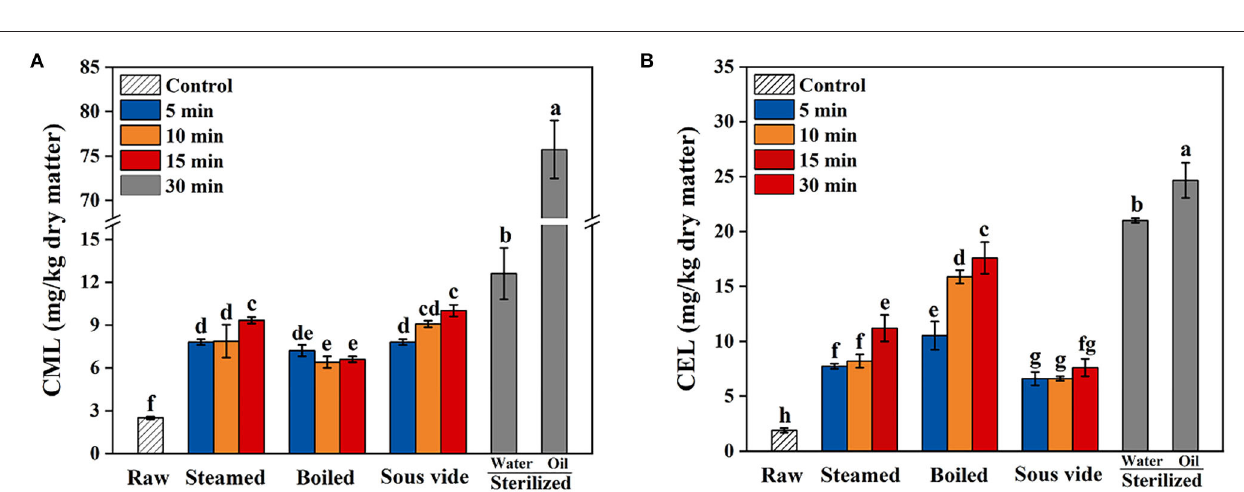
TBARS value of fried filets was about one-half of the boiled